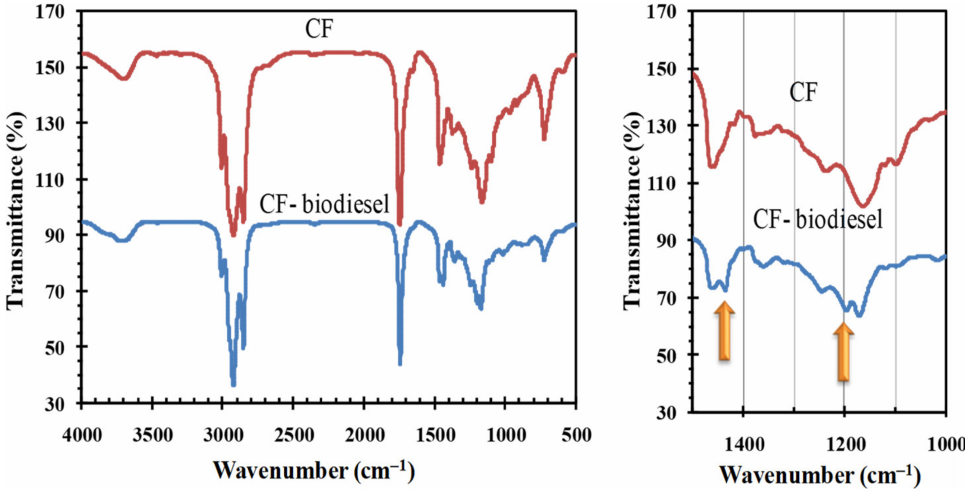
Figure 12. FTIR spectra of CF and